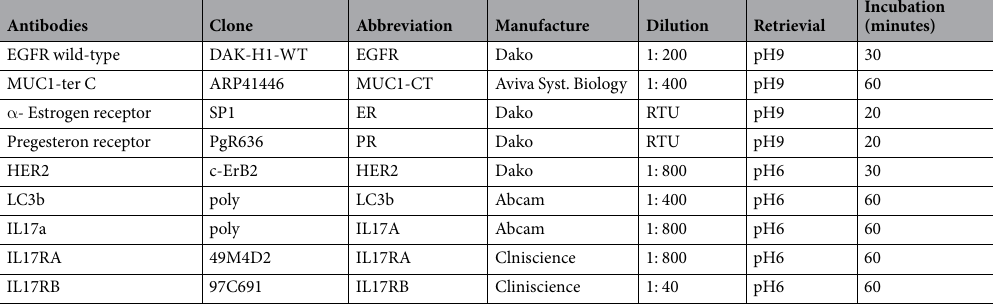
with a hydrogen peroxide phosphate buffered solution (EnVision Flex Peroxidase Blocking Reagent, Dako). After incubating with the primary antibodies, the immunological reaction was revealed by a polymer dextran coupled with the secondary antibody and peroxidase for 15 min (EnVision Flex HRP, Dako) and diaminobenzidine for 10 minutes (EnVision DAB + chromogen, Dako). Counterstaining was performed with hematoxylin for 10 min (EnVision Flex hematoxylin, Dako). Negative controls were obtained using mouse or rabbit IgG1 (Universal Negative Control Mouse or Universal Negative Control Rabbit, Dako) instead of the primary antibodies for each culture. No specific signal was observed. The primary antibodies, dilutions and antigenic retrieval are described in Table 1 (Table 1). Immunostaining quantification.